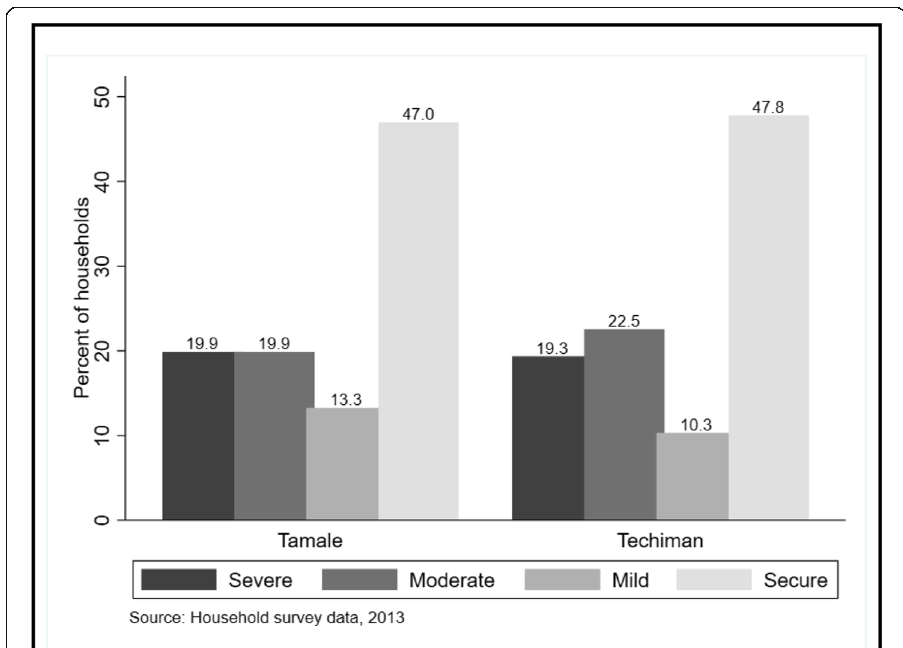
Fig. 1 Household food insecurity access prevalence (HFIAP) status by